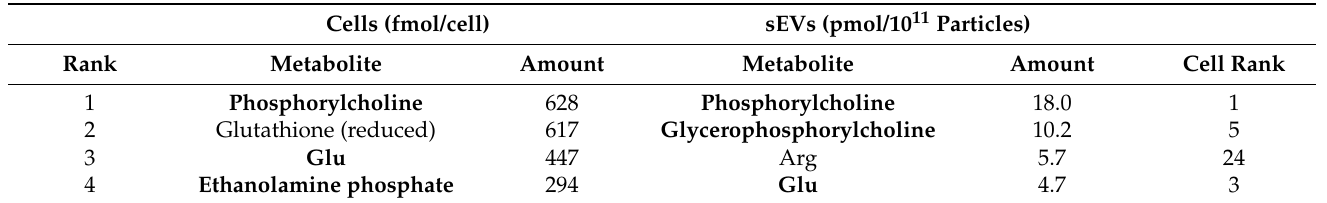
Table 1. Top 20 hydrophilic metabolites in cells and small extracellular vesicles (sEVs) under normoxia. Cells (fmol/cell) sEVs (pmol/10 11